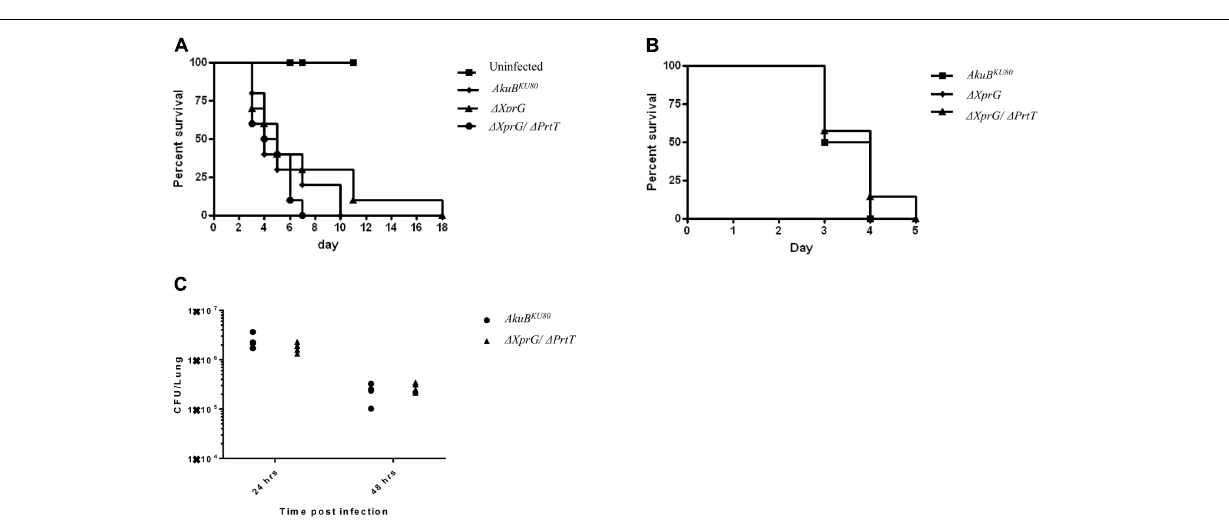
FIGURE 5 | Deletion of xprG and xprG / prtT , does not affect virulence in a neutropenic murine model of (A) pulmonary aspergillosis, (B) disseminated aspergillosis and (C) pulmonary fungal load in immunocompetent mice. Cortisone acetate plus cyclophosphamide (neutropenia model) were used to immunocompromise the infected mice (A,B) . Survival curves are shown for mice infected (A) intranasally with an inoculum of 2.5 × 10 5 conidia per mouse ( n = 10 mice/group) and (B) intravenously via the lateral tail vein with an inoculum of 2.5 × 10 5 conidia per mouse ( n = 7 mice/group). These experiments were repeated twice with similar results. (C) Immunocompetent mice were infected intranasally with an inoculum of 1 × 10 7 conidia per mouse ( n = 5 mice/group) and total lung fungal load (CFU/lung) assessed 24 and 48 h post-infection. (Additional histological analysis is presented in the Supplements- Supplementary Figure